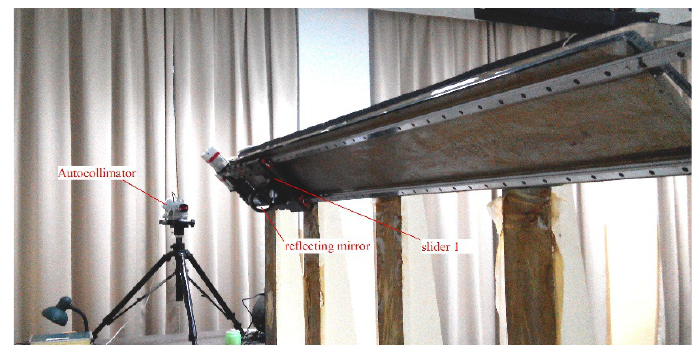
Figure 5. Autocollimator detection.